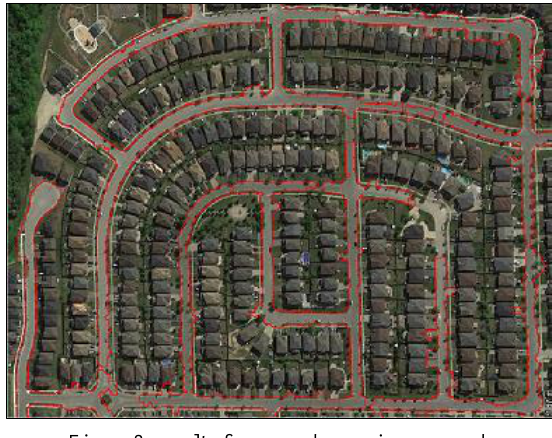
Figure 8. result of proposed grouping approach It can be seen from Figure 8 that most parts of the roads are properly extracted.